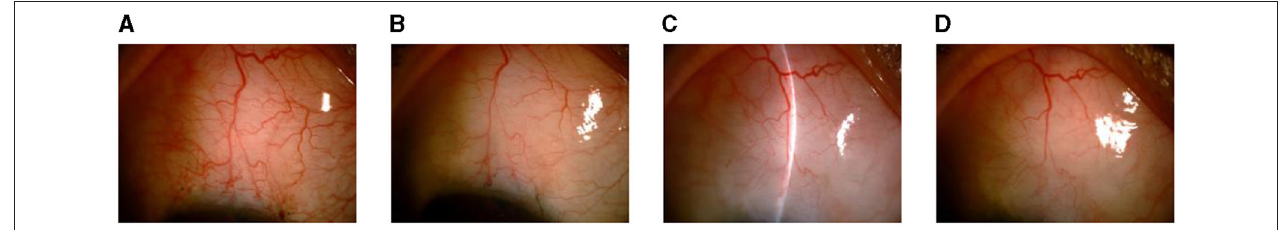
FIGURE 1 | Changes in the filtering blebs in the slit lamp images at different time points after surgery. (A) At 1 month after surgery. (B) At 3 months after surgery. (C) At 6 months after surgery. (D) At 12 months after surgery.